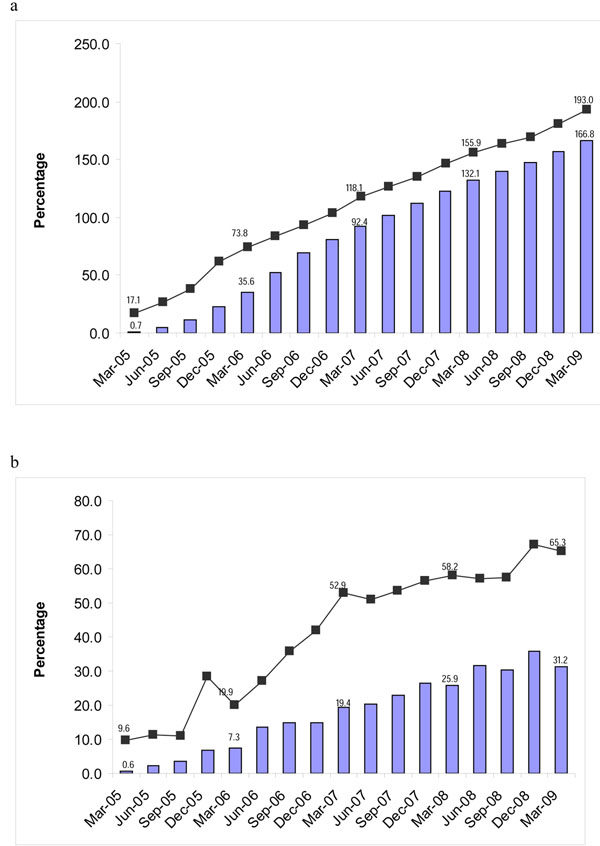
a) Proportion of FSW ever contacted and ever visited clinic in Maharashtra (Avahan CMIS 2005-2009). b) Proportion of FSWs contacted and visiting clinic in a month in Maharashtra (Avahan CMIS: 2005 - 2009)